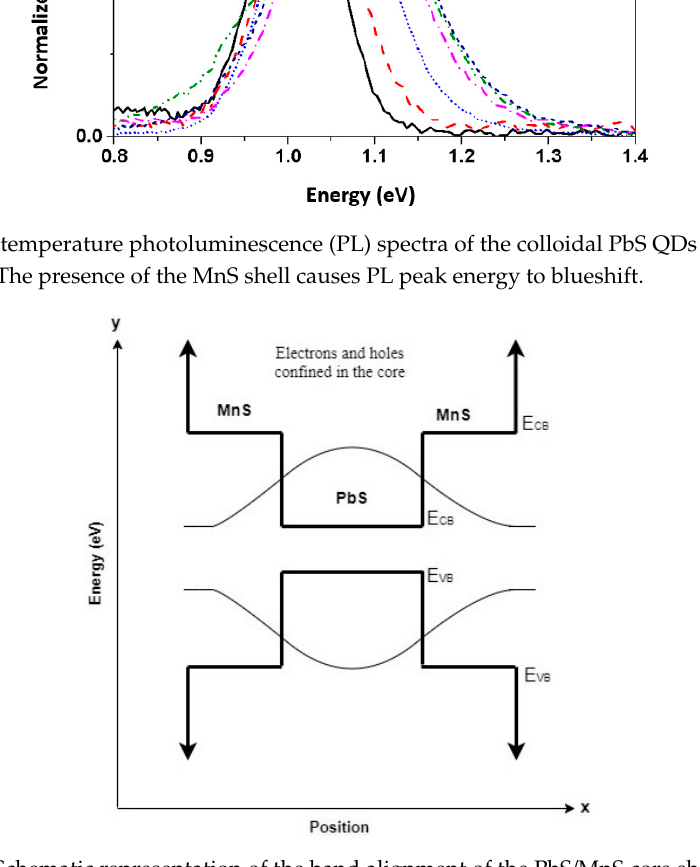
Figure 3. Schematic representation of the band alignment of the PbS/MnS core shell QDs.